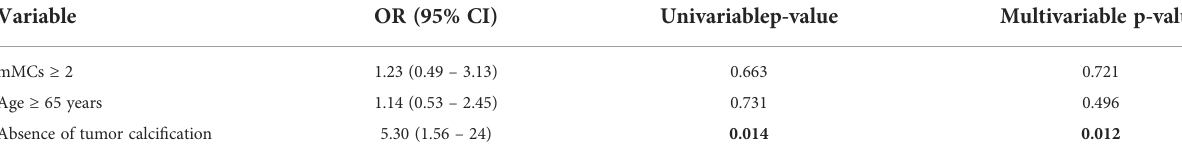
TABLE 4 Univariable and forced-entry multivariable logistic regression analysis predicting MIB-1 index ≥ 5%.